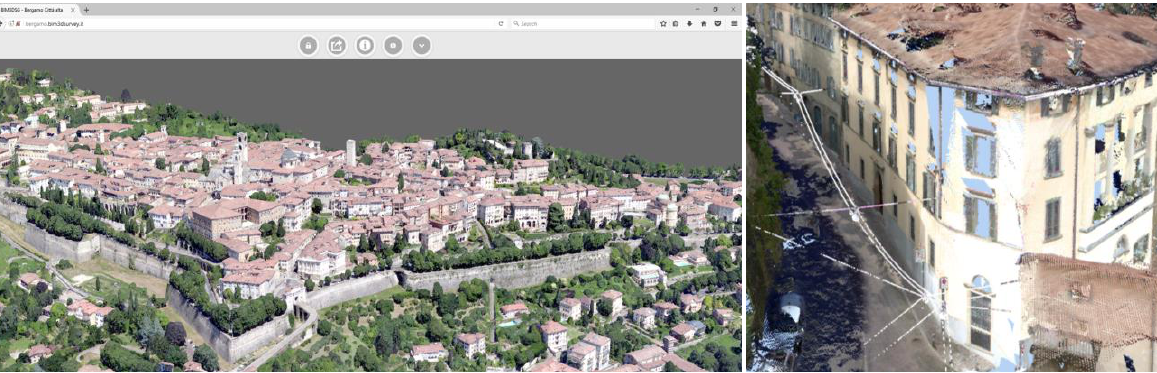
Figure 10. An overall view of the airborne and terrestrial merged point clouds within the BIM3DSG system (left) and close-up view (right).